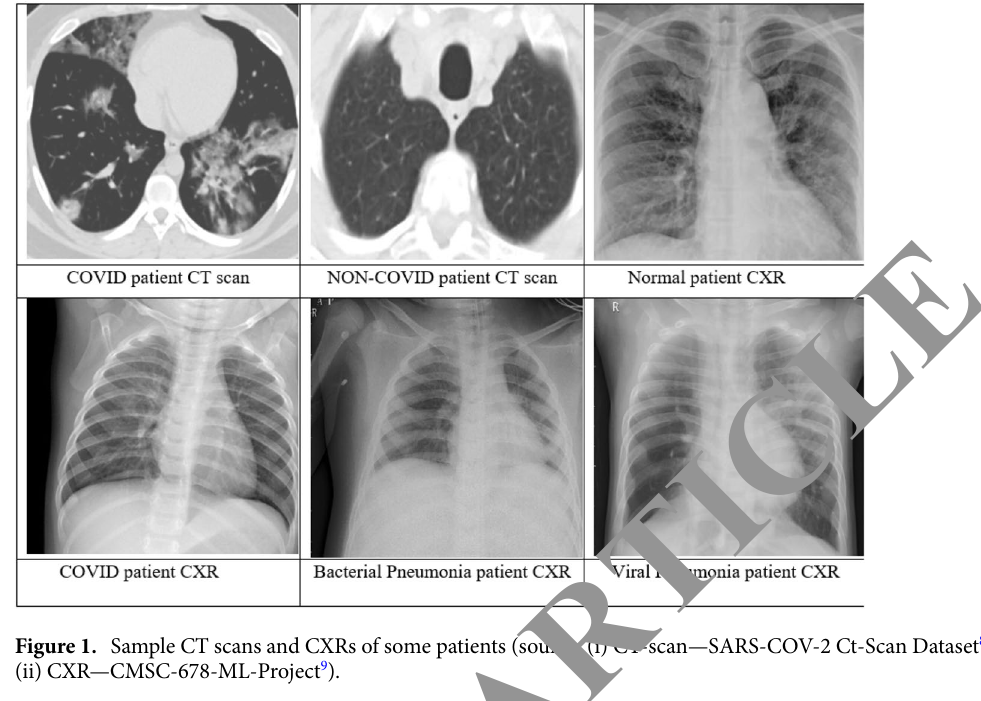
Figure 1. Sample CT scans and CXRs of some patients (source: (i) CT-scan—SARS-COV-2 Ct-Scan Dataset 8 , (ii) CXR—CMSC-678-ML-Project 9